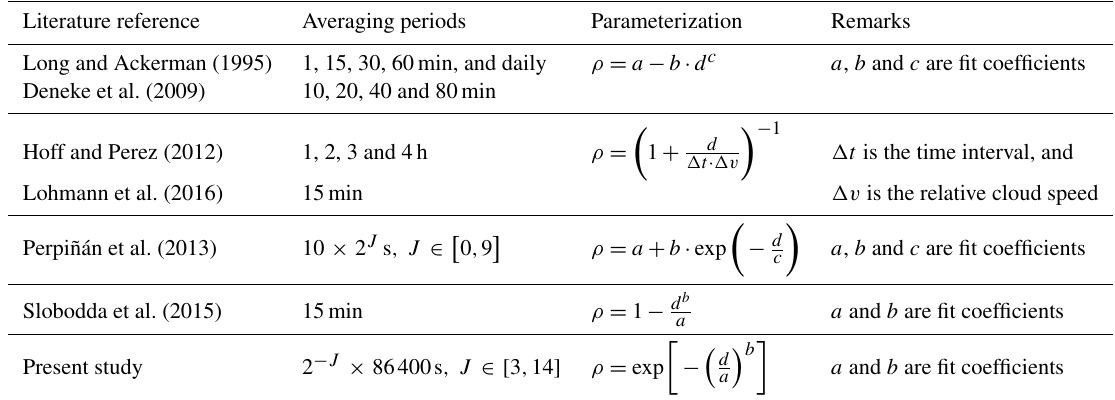
Figure 6. Spatial autocorrelation ρ as a function of station distance d for days with different sky conditions: (a) clear – 4 May 2013 (top row), (b) cirrus – 16 July 2013 (second row), (c) overcast – 9 June 2013 (third row), and (d) broken clouds – 25 April 2013 (last row). Here, S 3 corresponds to the wavelet smooth of global transmittance at 3h averaging timescale, while D 3 to D 9 represent the wavelet details of global transmittance. Table 4. Summary of various parameterizations used for modeling the behavior of spatial autocorrelation ρ as a function of the station distance d